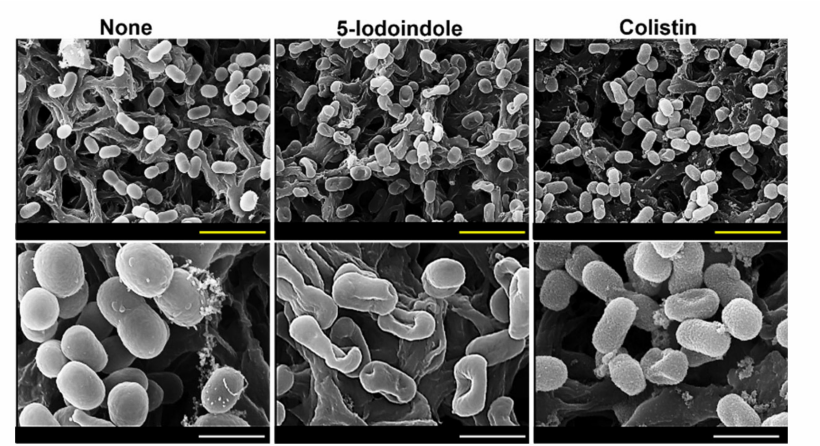
Figure 5. Membrane damage by 5-iodoindole in A. baumannii cells. Cells were grown with 5-iodoindole (125 µ g / mL) or colistin (200 µ g / mL; positive control) for 1 h and fixed on nylon membrane filters (0.45 µ m). Scale bar: yellow = 3 µ m, white = 1 µ m.